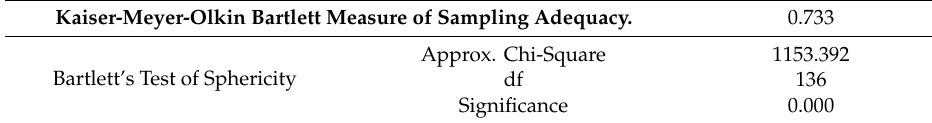
Extraction method: Principal component analysis. Table 3. Kaiser-Meyer-Olkin and Bartlett’s test of FA approach.